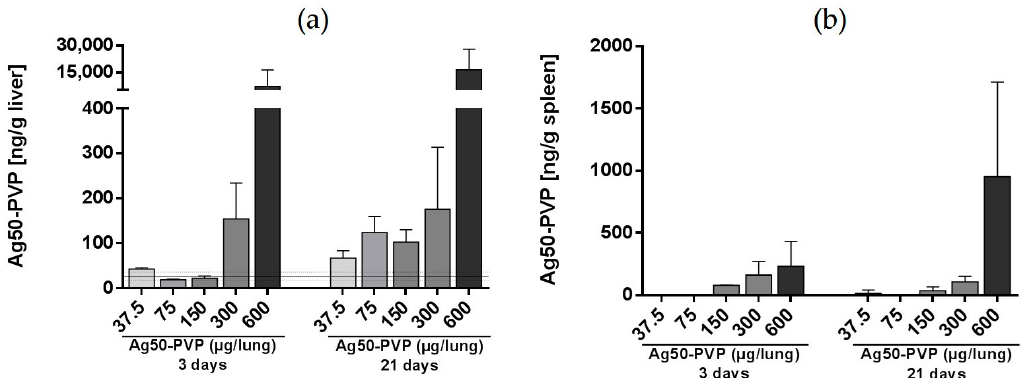
Figure 4. Time- and concentration-dependent changes of the Ag concentration in peripheral organs. Liver ( a ) and spleen ( b ) homogenates were analysed by inductively-coupled mass spectrometry (ICP-MS), three and 21 day after intratracheal instillation of 37.5–600 µ g Ag50-PVP per lung. Data were pooled from two experiments; values are the means ± standard deviation from three animals per group. Solid and dotted lines show control values from non-treated animals.